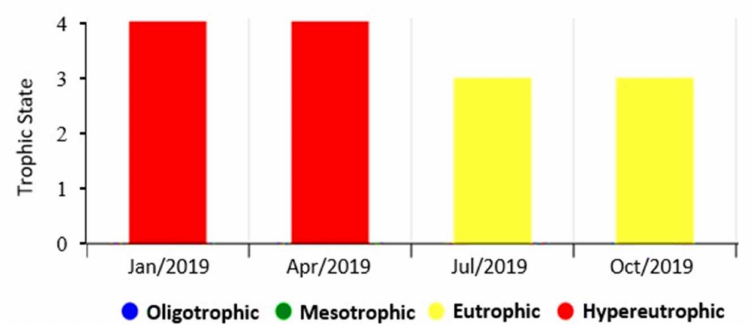
Figure 6. Trophic state of the Castanh ã o reservoir retrieved from quarterly measurements for the year 2019. Adapted from COGERH and made available at the electronic address http://www.hidro. ce.gov.br/hidro-ce-zend/acude/eutrofizacao (accessed on 17 January 2022). In 2019, no oligotrophic and mesotrophic conditions were found in the Castanh ã o as represented by the Trophic State Index (TSI): 1—Oligotrophic (24 ≤ TSI ≤ 44); 2—Mesotrophic (44 < TSI ≤ 54); 3—Eutrophic (54 < TSI ≤ 74); 4—Hypereutrophic (TSI > 74) [3].